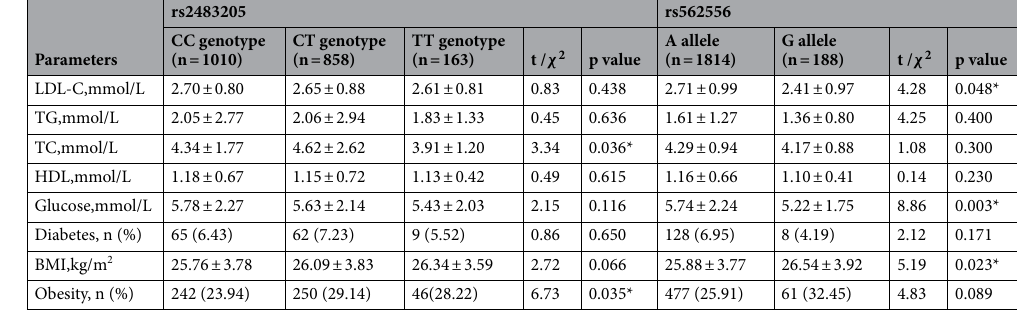
Table 6. The comparison of CAD associated risk factors between different genotypes of rs2483205 and rs562556 polymorphisms. LDL-C low density lipoprotein-cholesterol, TG triglyceride, TC total cholesterol,